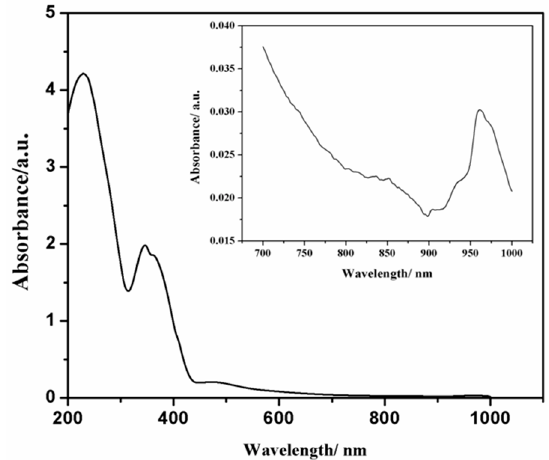
Figure 1. UV/Visible spectrum of 1 , recorded in acetonitrile at 300K. Inset: zoom of the high wavelength region showing the d-d band.